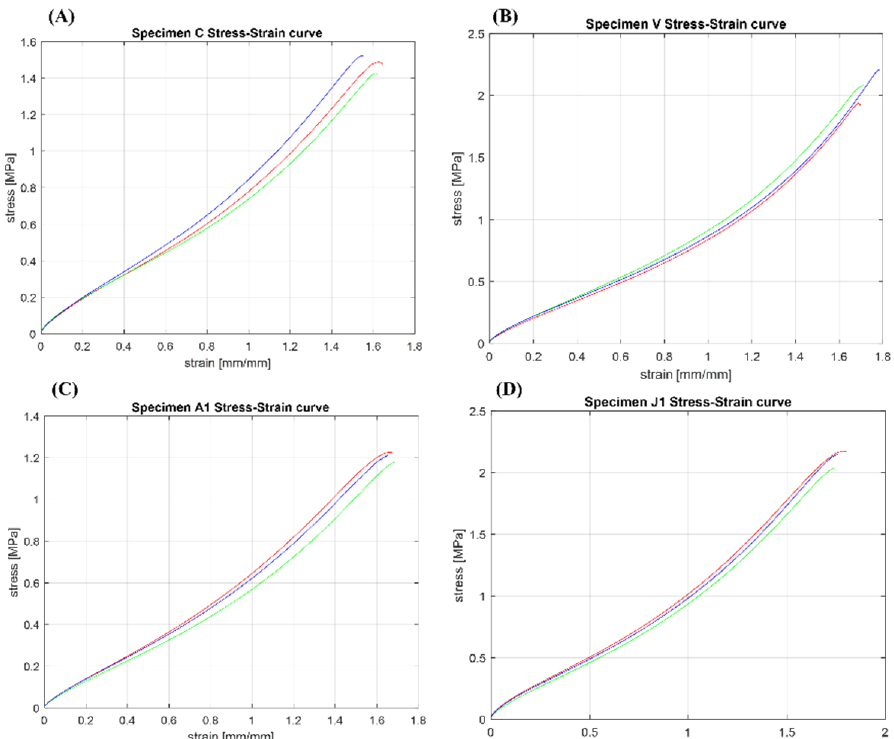
Figure 12. The most significant stress–strain curves obtained after mechanical testing of patterned specimens. ( A ) Tendon-Like (TL) pattern: C = Inner Layer: Shore hardness A70—Middle Layer: Shore hardness A60—Outer Layer: Shore hardness A70, and Matrix: Shore hardness A60. ( B ) Tendon-Mimic (TM) pattern: V = Variant %: Fiber 60%—Matrix 40%, Fiber: Shore hardness A70, and Matrix: Shore hardness A50. ( C ) Bamboo-Like (BL) pattern: A1 = Inner Layer: Shore hardness